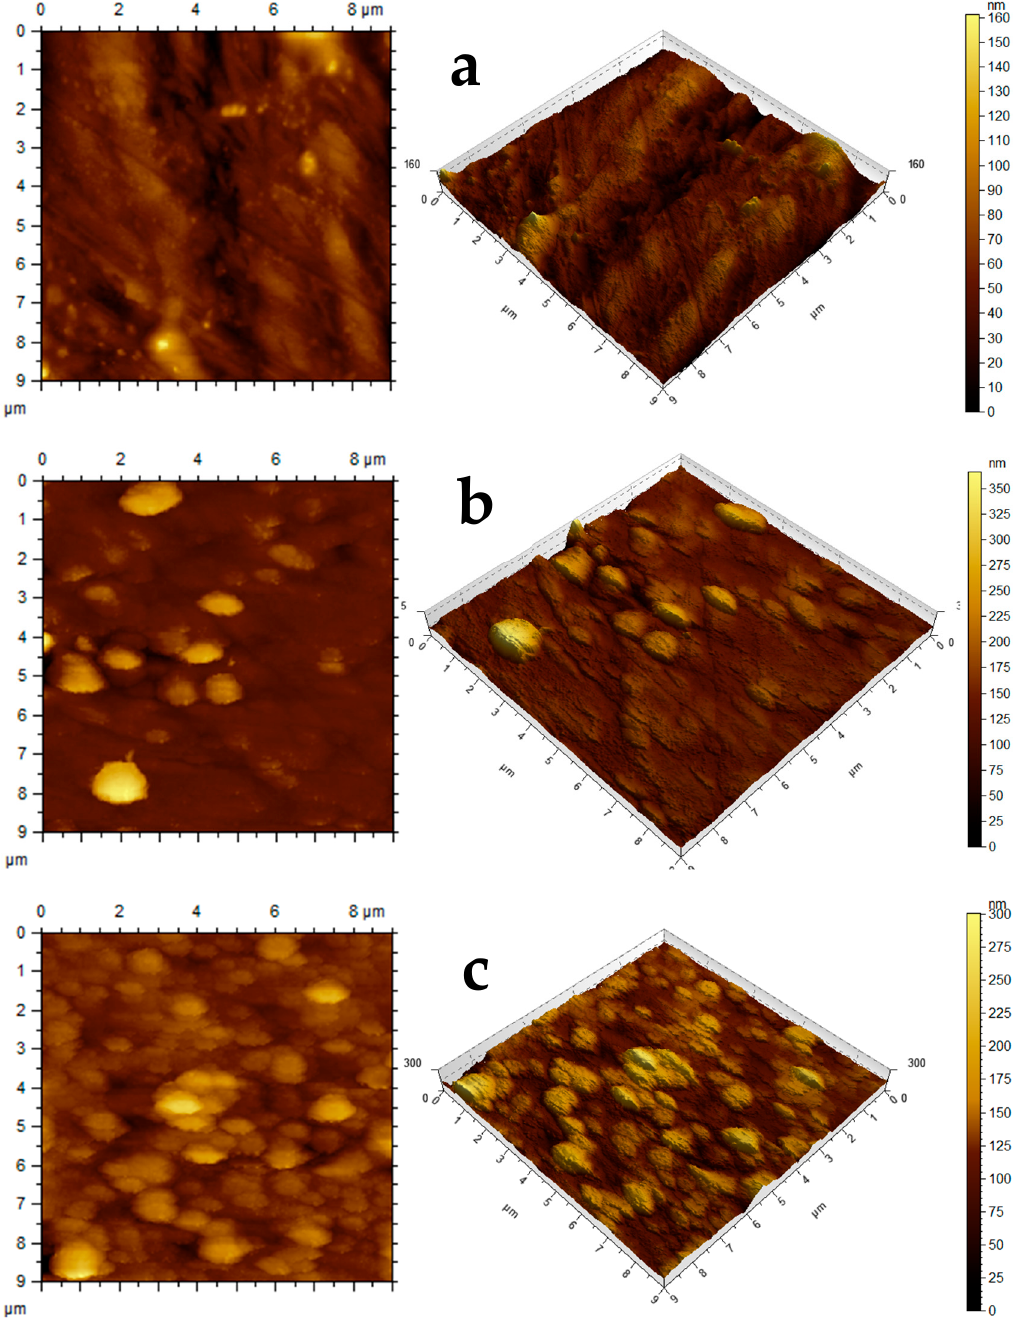
Figure 7. AFM images of the samples: ( a ) blank control group; ( b ) hemimorphite + Na 2 S·9H 2 O + Pb 2+ ; ( c ) hemimorphite + Pb 2+ + Na 2 S·9H 2 O + Pb 2+ .